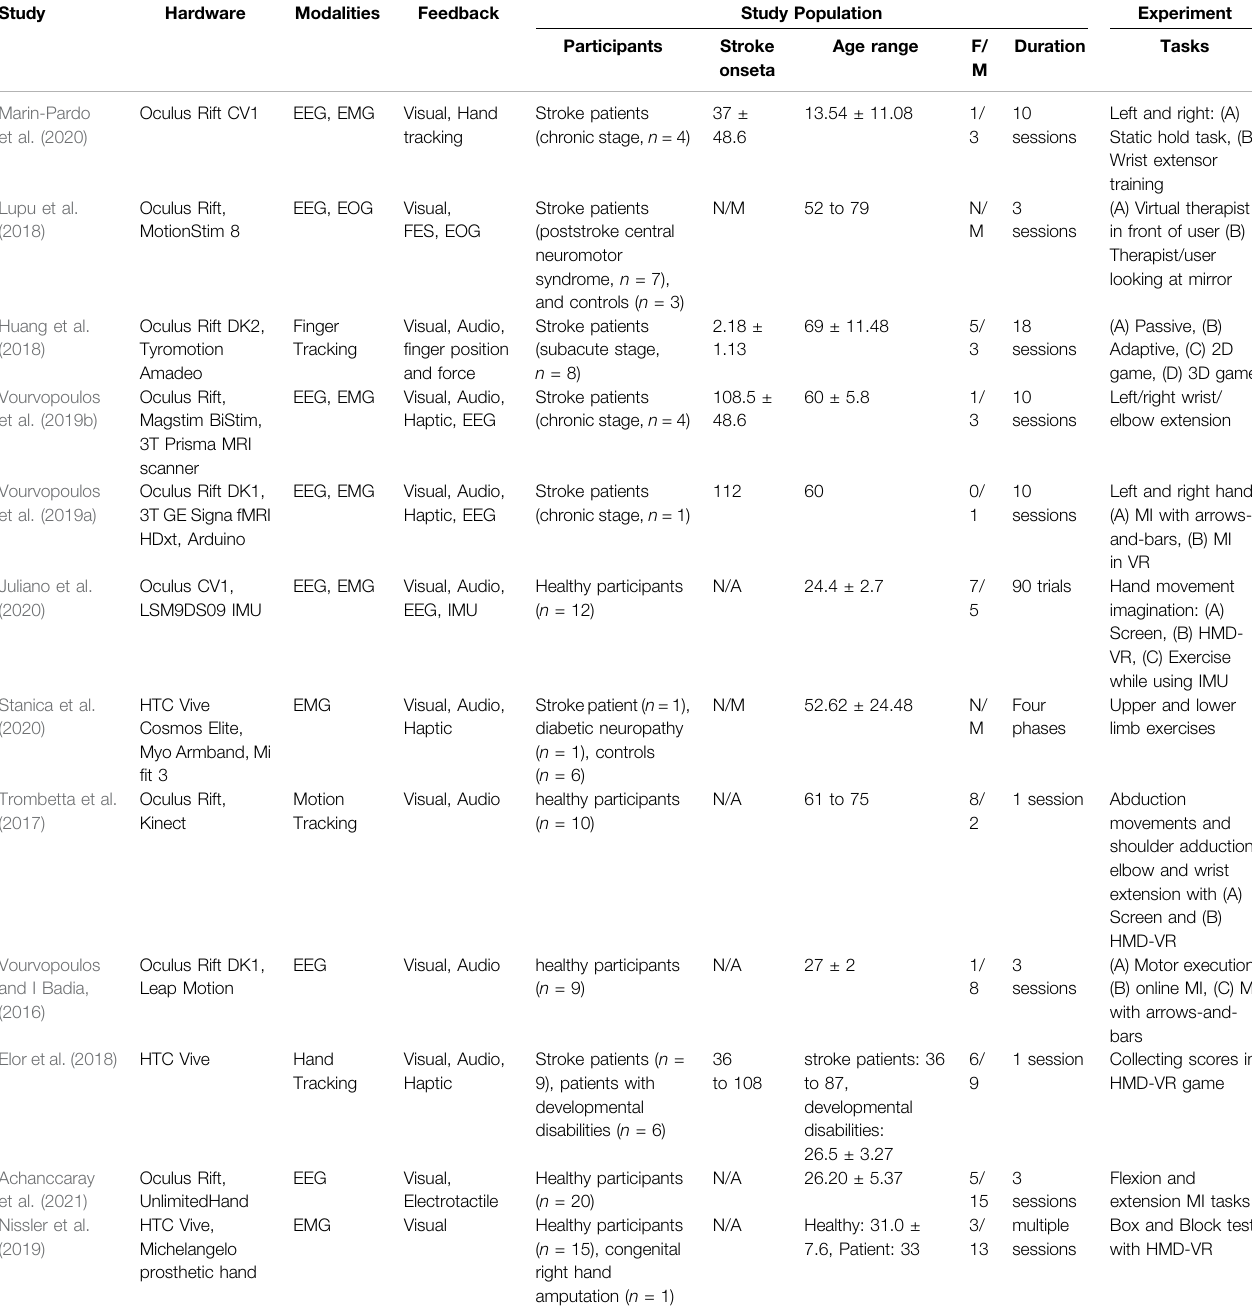
TABLE 1 | HMD-VR rehabilitation systems and utilized technologies, devices and study design.